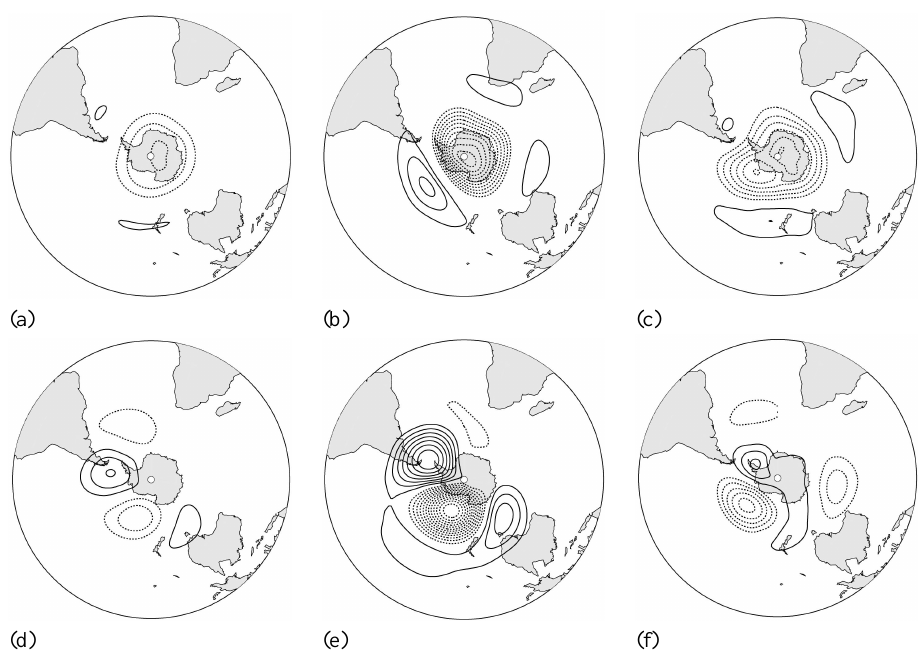
Fig. 5. (a) First EOF of 833hPa geopotential height for the 800yr run of the atmosphere-only model (16.4% of explained variance). (b) First EOF of 833hPa geopotential height for the 800yr run of the coupled model (13.8% of explained variance). (c) First EOF of observed austral wintertime geopotential height in the lowest model level (NCEP-NCAR reanalysis data for 1948–2003) (31.7% of explained variance). (d) Second EOF of 833hPa geopotential height for the 800yr run of the atmosphere-only model (9.4% of explained variance). (e) Second EOF of 833hPa geopotential height for the 800yr run of the coupled model (9.8% of explained variance). (f) Second EOF of observed austral wintertime geopotential height in the lowest model level (NCEP-NCAR reanalysis data for 1948–2003) (12.2% of explained